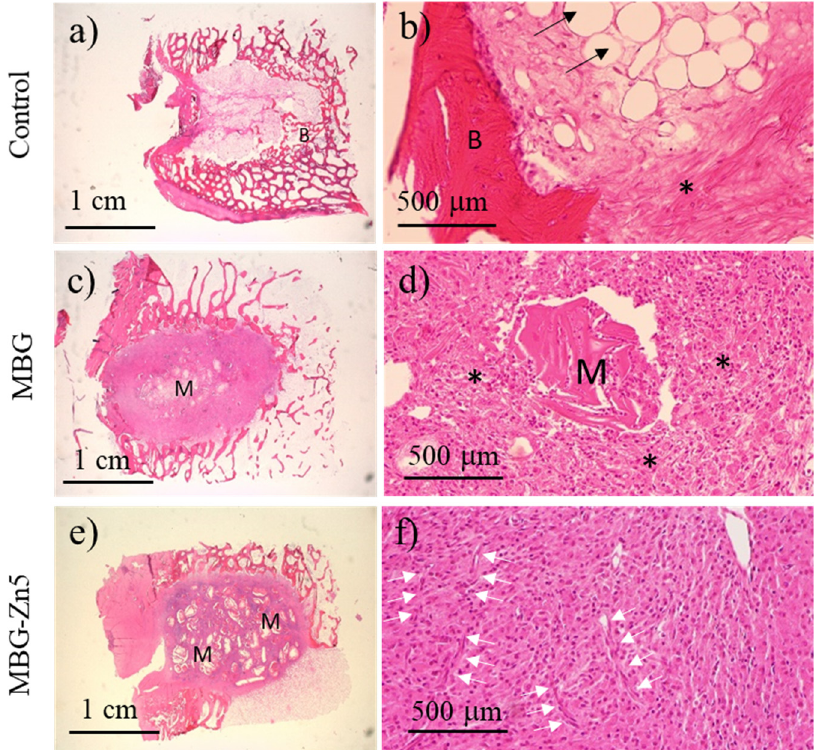
Figure 9. Histological images 6 weeks after implantation of control (a and b), MBG (c and d), and MBG-Zn5 (e and f) (left column: magnification ×3; right column: magnification ×20). (B) Bone tissue. (*) Inflammatory component. (M) Implanted material. (Black arrows) adipocytes. (White arrows) Blood vessels.